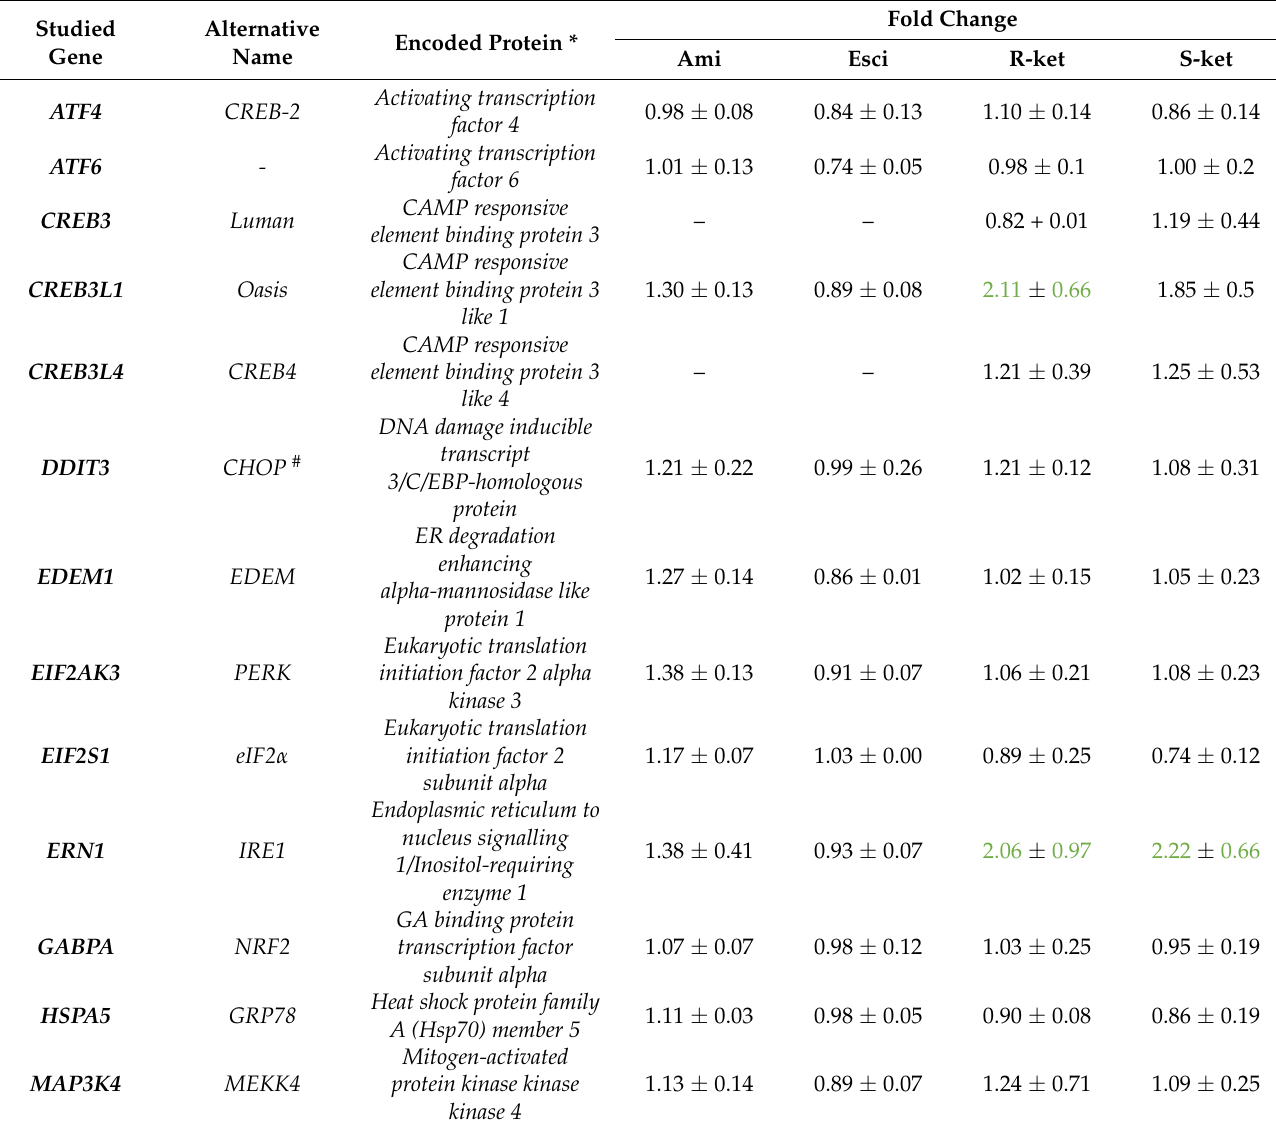
Table 1. Effects of amitriptyline (Ami), escitalopram (Esci), R-ketamine (R-ket) and S-ketamine (S-ket) on gene expression of ER stress-responsive genes. The fold change values >2 were marked in green. Data are presented as the mean ± SEM and expressed as fold change vs. untreated control cells. –: not studied; * According to https://www.proteinatlas.org/, accessed on 1 February 2022; # more frequent in usage in the